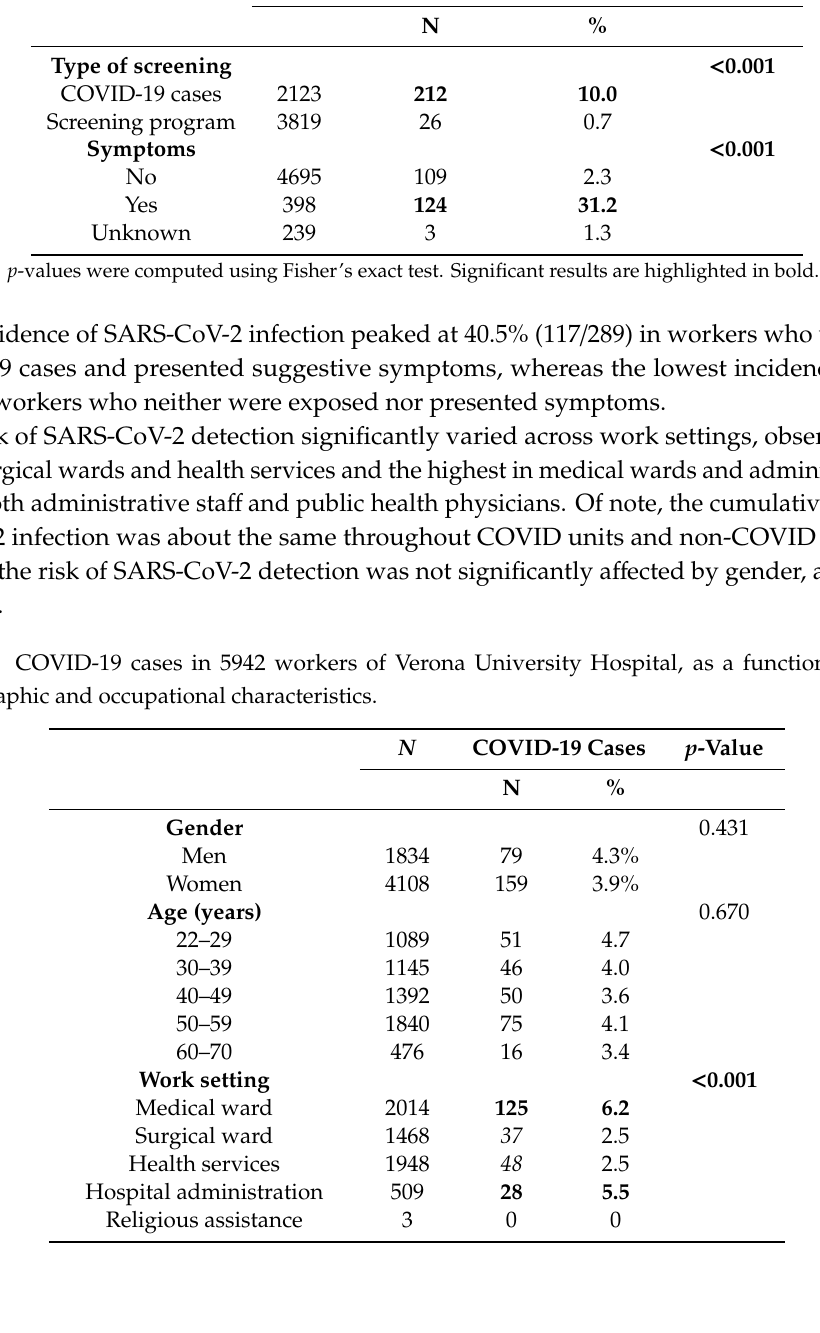
Table 2. Factors a ff ecting SARS-CoV-2 detection in 5942 workers of the University Hospital of Verona. N p -Value N < 0.001